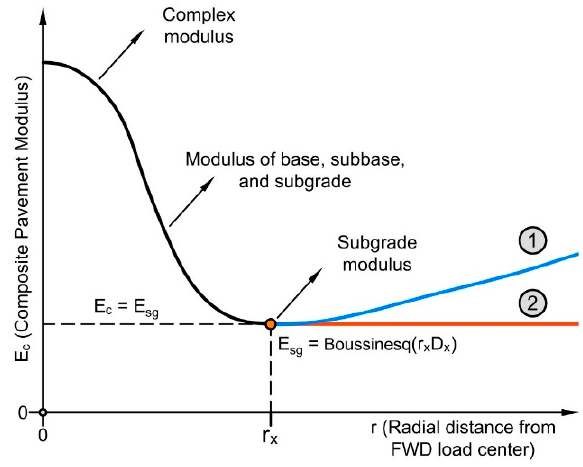
Figure 7. Composite modulus vs. radial distance plot [13].